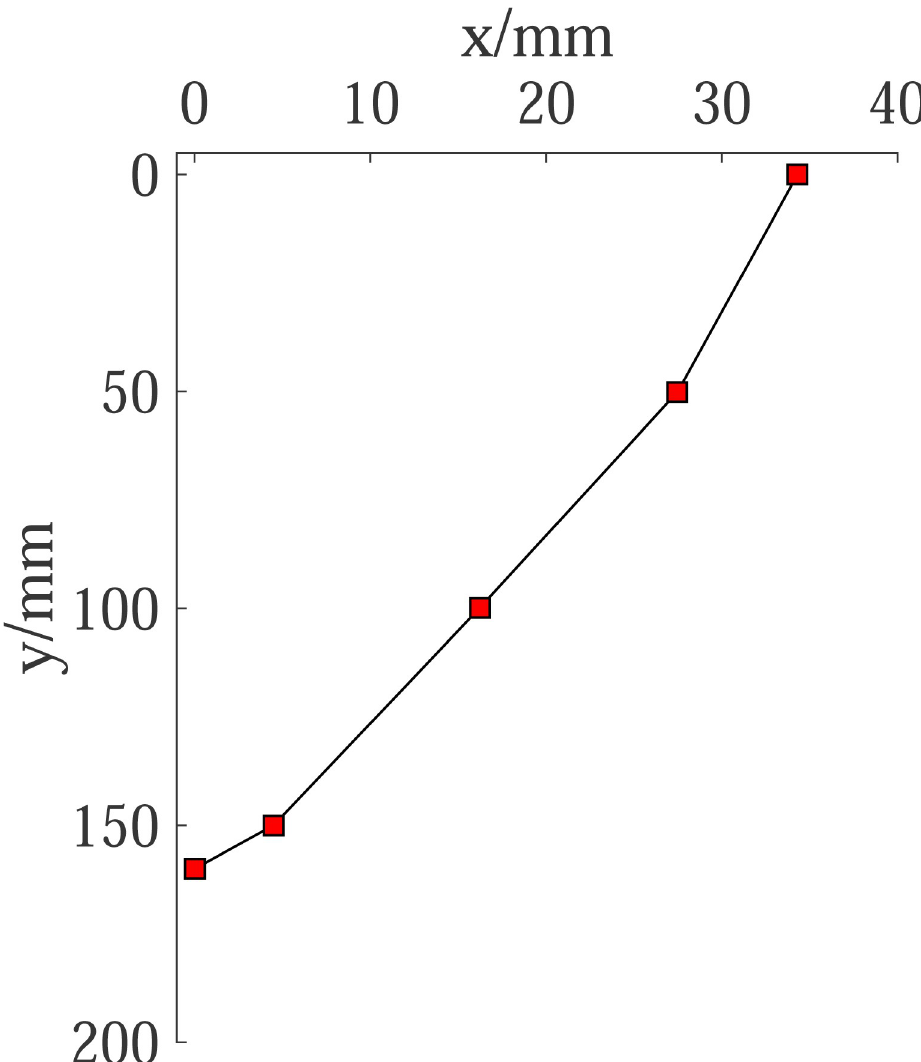
Fig 18. Displacement of cantilever retaining